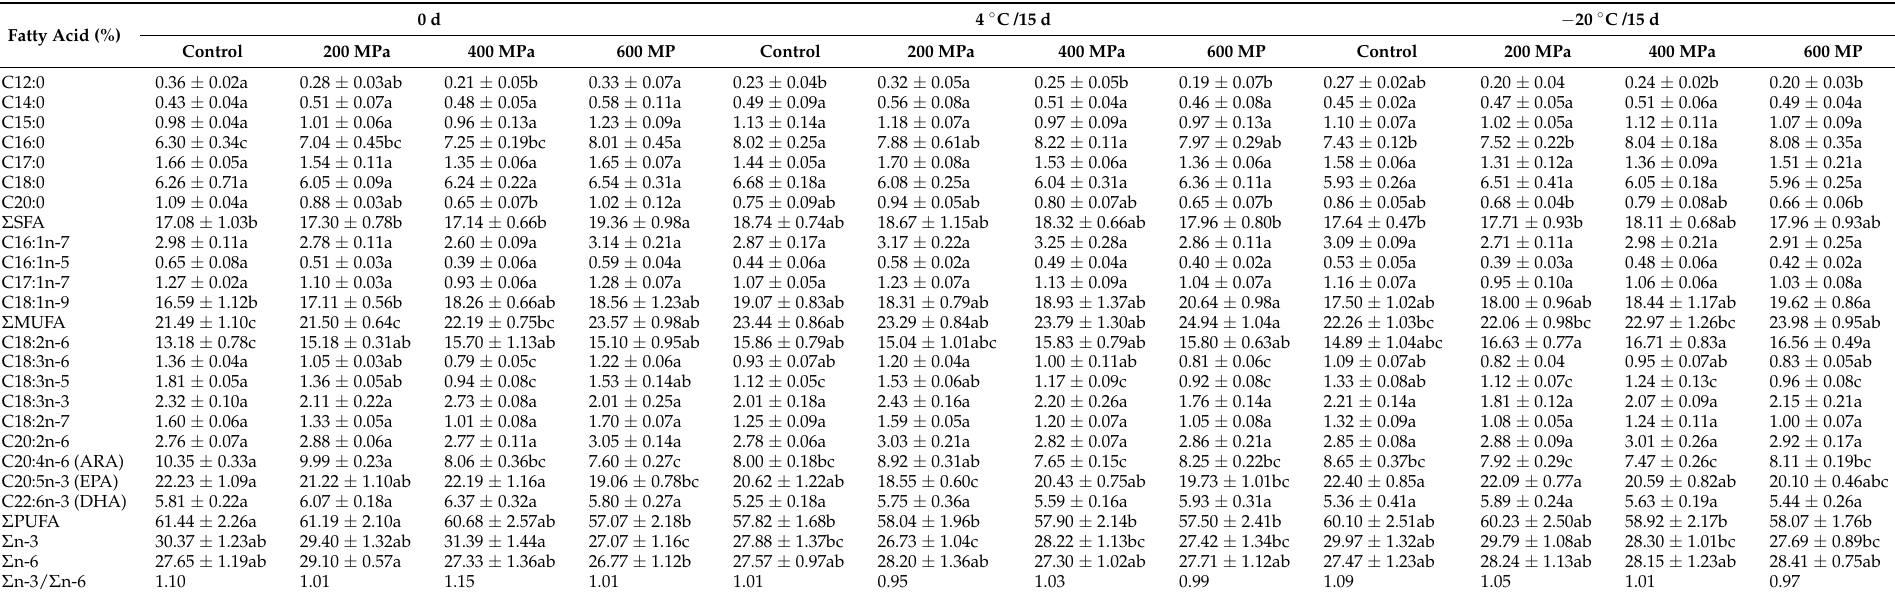
Table 1. Changes in fatty acid profiles of HHP treated red claw crayfish with different